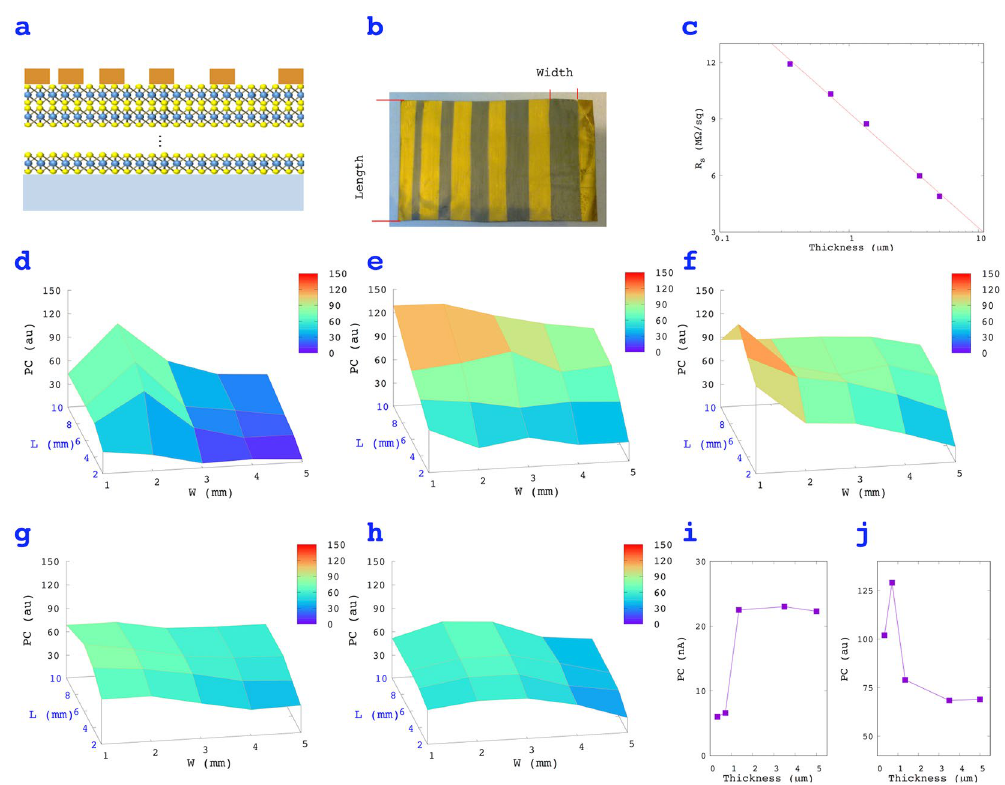
Figure 5. The influence of the geometry of a MoS 2 film on the PC response. ( a ) A schematic drawing of the structure of the device, ( b ) a photograph of the device, ( c ) sheet resistance of films with various thicknesses, ( d – h ) maps of the PC (au) of MoS 2 films with thicknesses of 0.35, 0.72, 1.36, 3.5, and 5 µ m, ( i , j ) the absolute and normalized photocurrent change of 10 × 2 mm channels, PC (nA) and PC (au), at various